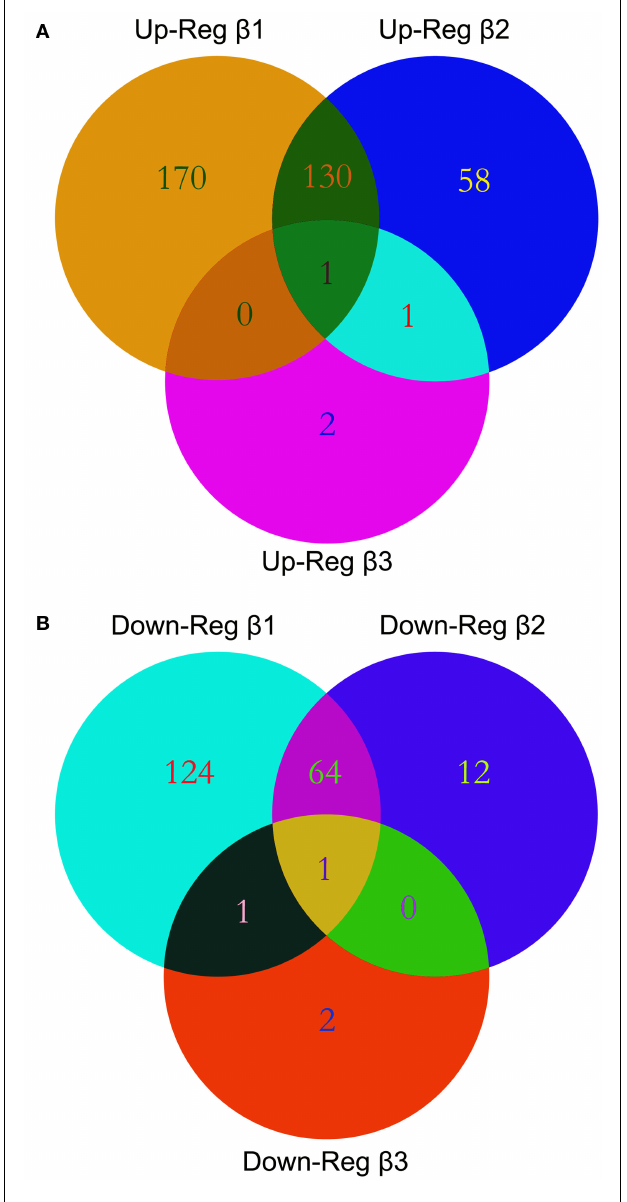
FIGURE 1 |Venn diagrams. Multiple microarray experiments were designed to detect differential expression of transcripts withTGF β treatment and were compared usingVenn diagrams. List of differentially expressed genes with their accession IDs were uploaded to GeneVenn, query was run, and the detected numbers and gene lists were exported to MS Excel. Graphical figure is illustrated using the Adobe Photoshop (Adobe Inc, CA, USA). Relations among the list of altered genes withinTGF β treatment groups are depicted as intersections or uniqueness. A significant overlap of differentially expressed genes was observed between theTGF β 1 andTGF β 2 treatment groups both in the upregulated (A) or downregulated (B) gene